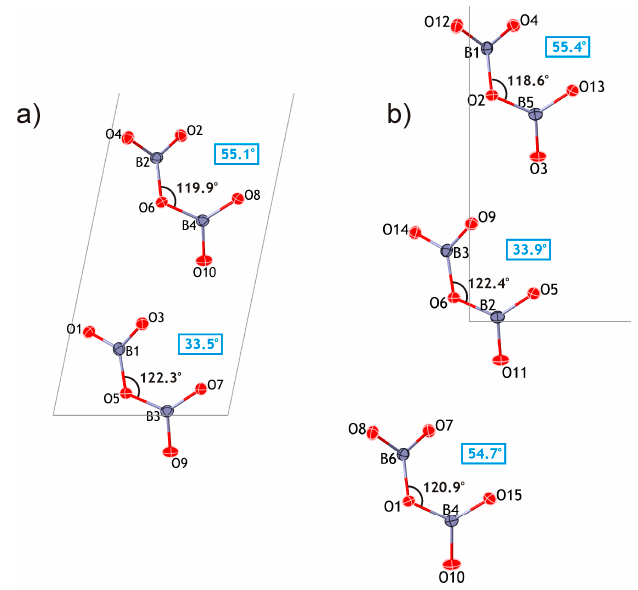
Figure 5. The arrangements of diborate groups in the crystal structures of kurchatovite ( a ) and Figure 5. Thearrangementsofdiborategroupsinthecrystalstructuresofkurchatovite( a )andclinokurchatovite clinokurchatovite ( b ), featuring their angular characteristics (the B-O-B angles are shown in black; ( b ), featuring their angular characteristics (the B–O–B angles are shown in black; the values in blue boxes the values in blue boxes correspond to the δ angles between the planes of the adjacent BO 3 triangles). correspond to the δ angles between the planes of the adjacent BO 3